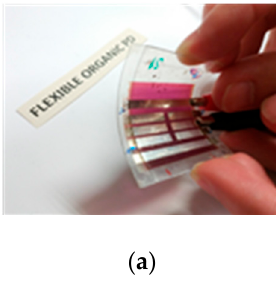
Figure 2. ( a ) Flexible OPD; ( b ) flexible electronic driver.